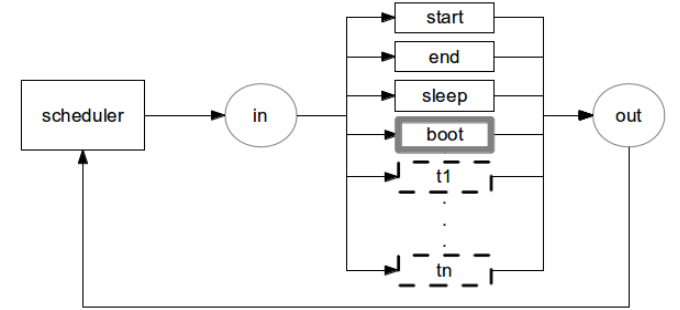
Figure 11. Schematic representation of the Application